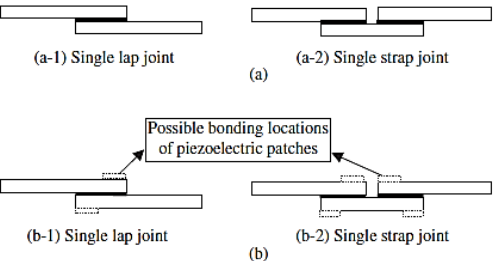
Figure 10. ( a ) Commonly used adhesive bonded joints; ( b ) the smart joints with piezoelectric patches bonded to them [57].